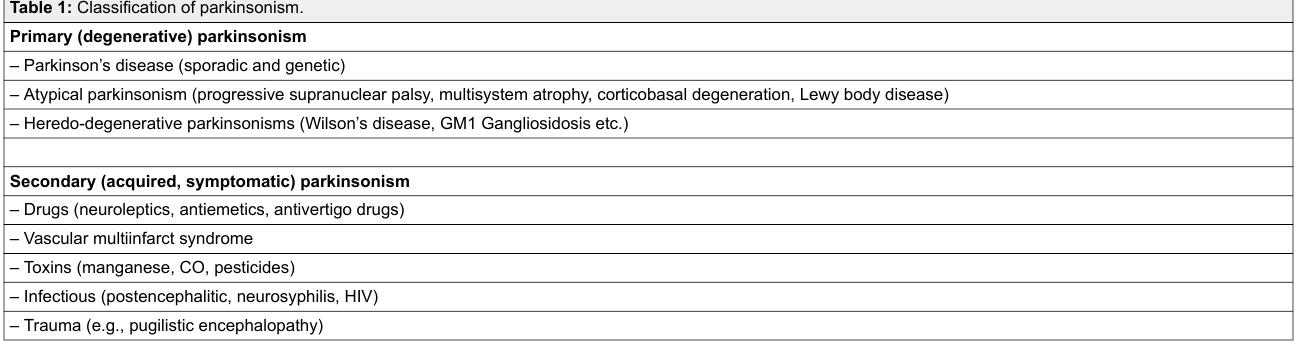
Table 1: Classification of parkinsonism. Primary (degenerative)